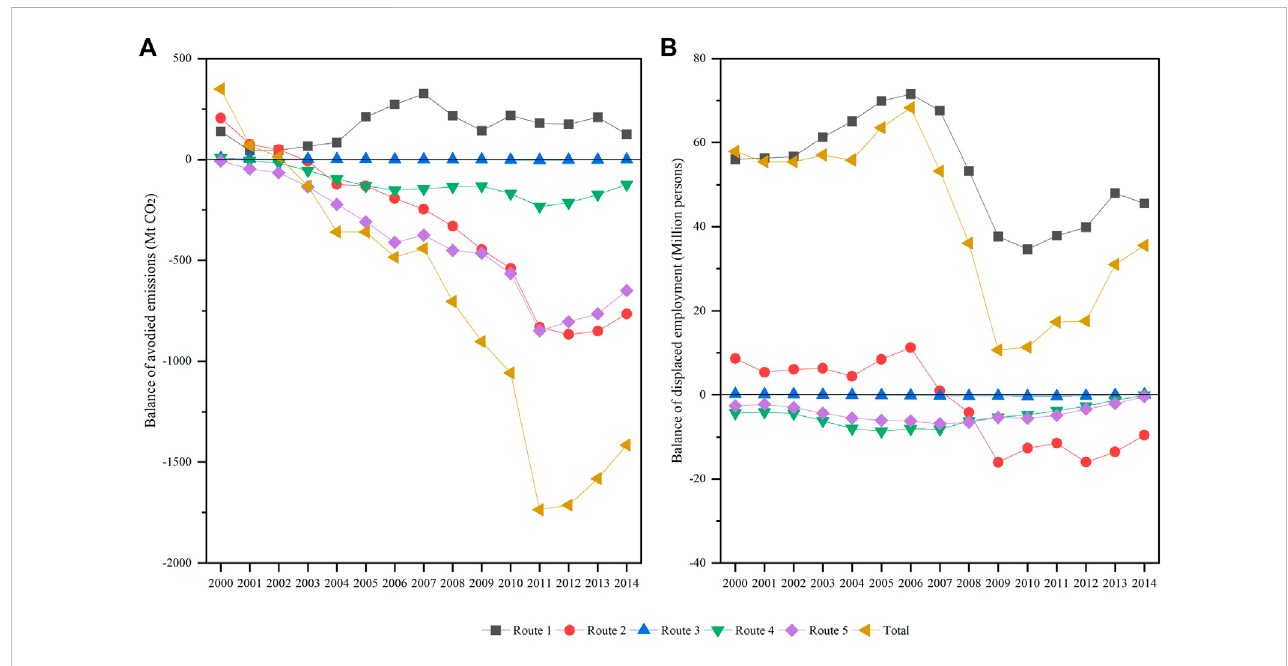
FIGURE 5 Environmental (A) and employment (B) impacts of gross international